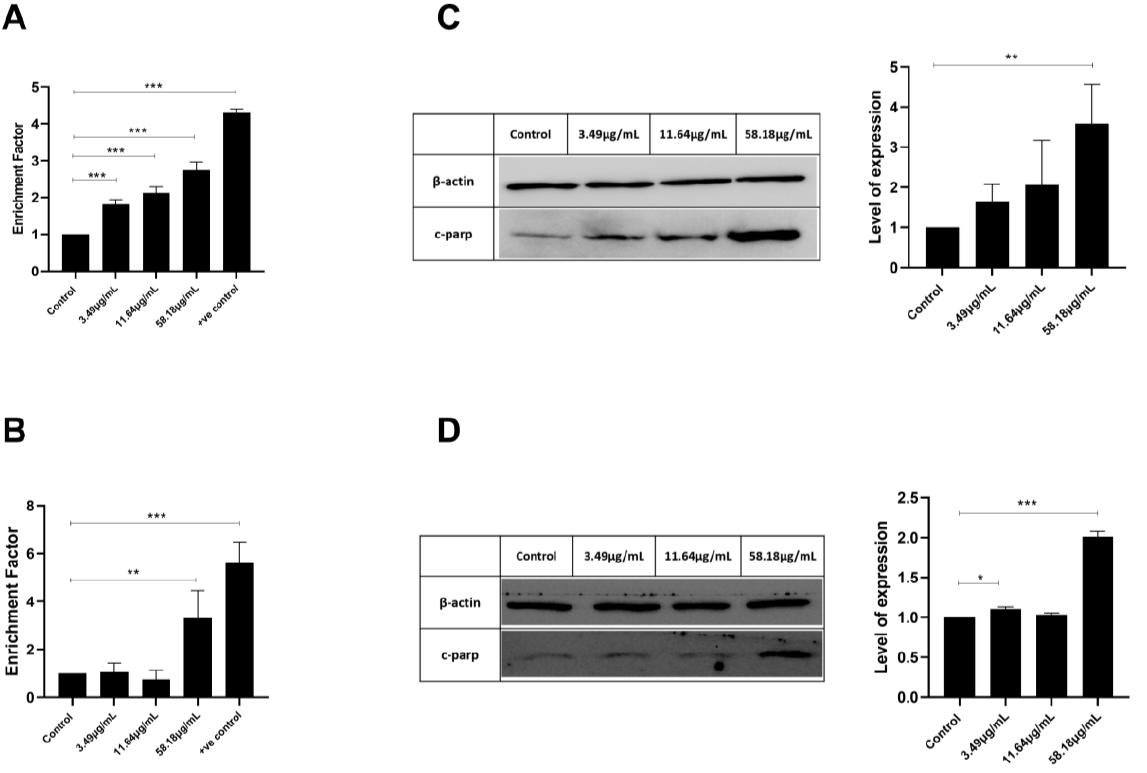
Figure 3. ScBEE induces DNA fragmentation in a dose-dependent manner as quantified via cell death detection ELISA in ( A ) MDA-MB-231 and ( B ) MCF-7 cells. Western blot analysis revealed the increased expression of cleaved PARP with increased treatment concentration for 24 h in ( C ) MDA-MB-231 and ( D ) MCF-7 cells. Significant differences are reported; * indicates a p -value of 0.01 < p < 0.05, ** indicates a p -value of 0.001 < p < 0.01 and *** indicates a p -value of 0.0001 < p < 0.001. The full-length blots of all trials are reported as Supplementary Figures S1 and S2.